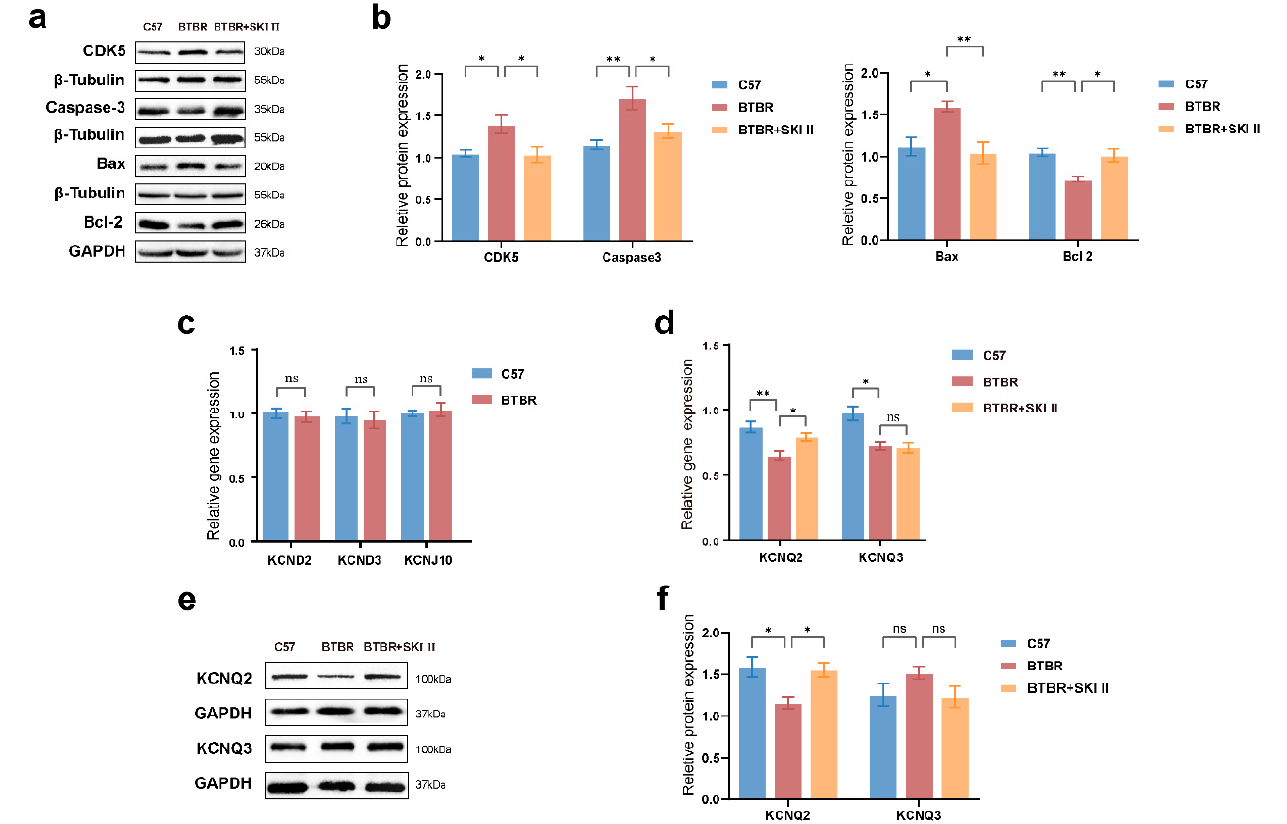
Figure 8. ApoA-I-related pathway regulates the expressions of proteins related to the apoptosis process and the KCNQ2 channel in the hippocampus of the mice. ( a , b ) Representative Western blotting bands and quantification of the apoptosis proteins, CDK5/ β -tubulin, caspase-3/ β -tubulin, Bax/ β -tubulin and Bcl-2/GAPDH ratios. ( c ) Quantification of mRNA expression of KCND2, KCND3 and KCNJ10 channels. ( d ) Quantification of KCNQ2, and KCNQ3 mRNA expression. ( e , f ) Representative Western blotting bands and quantification of the M channel proteins, KCNQ2/GAPDH, and KCNQ3/GAPDH ratios. N = 8–10 per group. All data are shown in bar diagrams, which reflect the arithmetic mean ± standard error of the mean. * p < 0.05, ** p < 0.01.